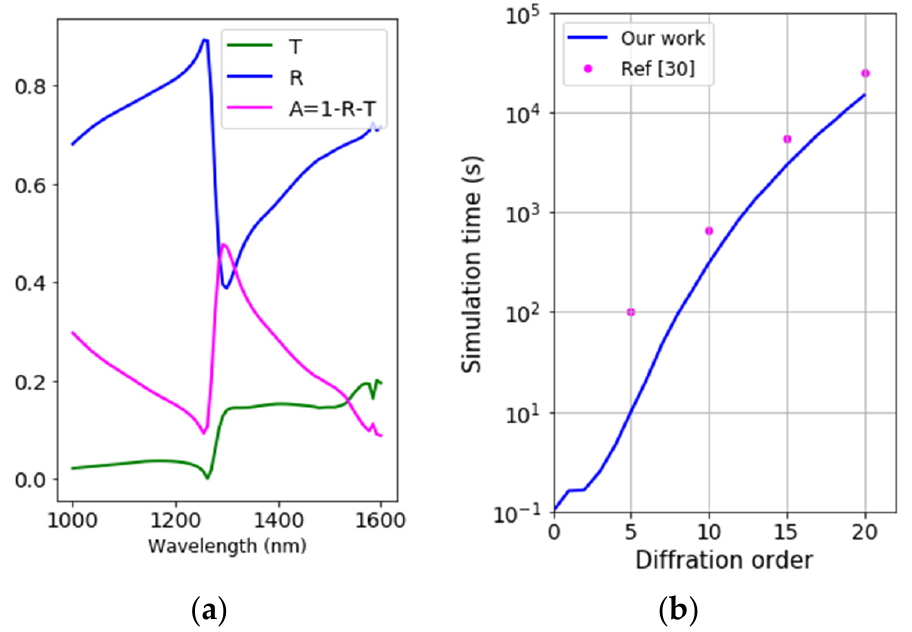
Figure 7. ( a ) Simulated spectra of the plasmonic nanostructure, using 81 wavelength points from 1000 to 1600 nm, P x = P y = 950 nm, CD = 500 nm, h (cid:2885)(cid:2922)(cid:2869) = 100 nm , h (cid:2903)(cid:2919)(cid:2899)(cid:2870)(cid:2870) = 50 nm , h (cid:2903)(cid:2919)(cid:2871) = 50 nm, and h (cid:2891)(cid:2915)(cid:2872) = 1000 nm . ( b ) RCWA simulation time of both studies as a function of diffraction order in x- and y-directions.